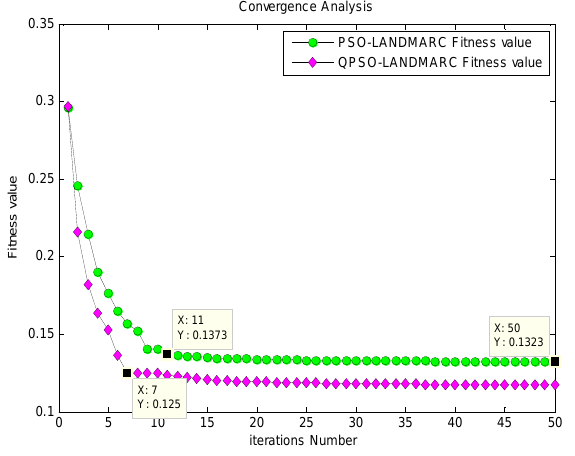
Figure 8. Convergence analysis.